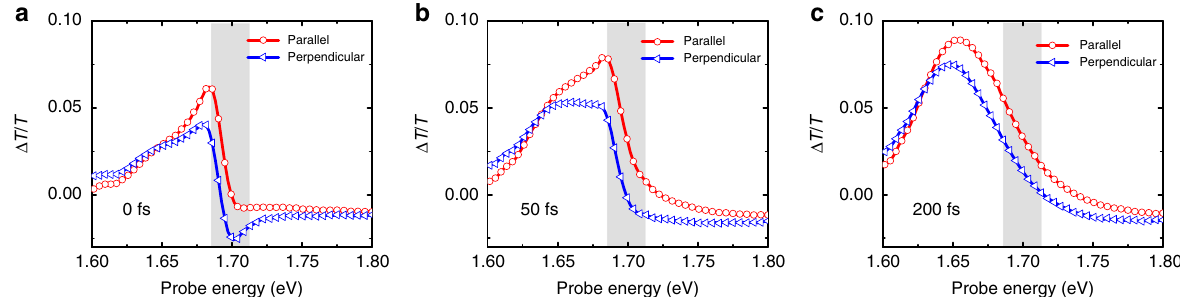
Fig. 2 Ultrafast polarization selective transient absorption. a – c Spectrally resolved sub-picosecond transient absorption response of CH 3 NH 3 PbI 3 hybrid perovskite thin fi lms at the indicated time delays. The sample was excited with laser pulses of energy 1.7 eV (FWHM approximately 25 meV, shaded area), pulse length of approximately 50 fs, and excitation fl uence approximately 20 µ J cm − 2 . The change in the transmission of the probe was measured at the indicated time delays with the linear polarization of the probe pulse aligned either parallel (red) or perpendicular (blue) to the linear polarization of the pump pulse. We observe a stronger increase in transmission (photoinduced bleach signal) when the pump and probe pulse polarizations are aligned parallel. The differences observed in the transient spectral dynamics indicate that the carrier populations probed in parallel and perpendicular con fi gurations undergo different relaxation